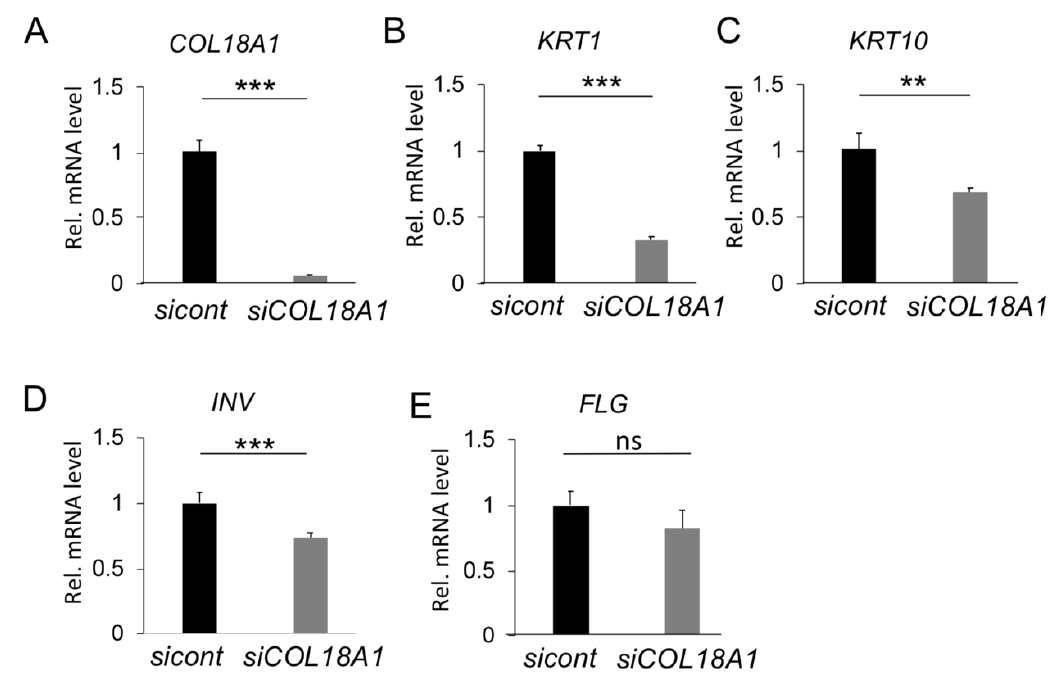
Figure 3. Functional analysis of COL18A1 knockdown in vitro. SiRNA targeting the COL18A1 gene was transfected into TR146 cells, then transfected cells was subsequently cultured for 7 days in a 3D culture method. The mRNA expression level of COL18A1 dropped sharply by COL18A1 siRNA transfection, on the seventh day of culture ( A ). Consequently, the gene expression of KRT1 and KRT10 ( B , C ) and INV ( D ) also decreased remarkably, except for that of FLG ( E ). Bars represent the mean values and standard deviation (+/−SD) ( n = 3). ** p < 0.01, *** p < 0.001, ns: no significant difference (Student’s t -tests). Results are representative of at least three independent experiments.